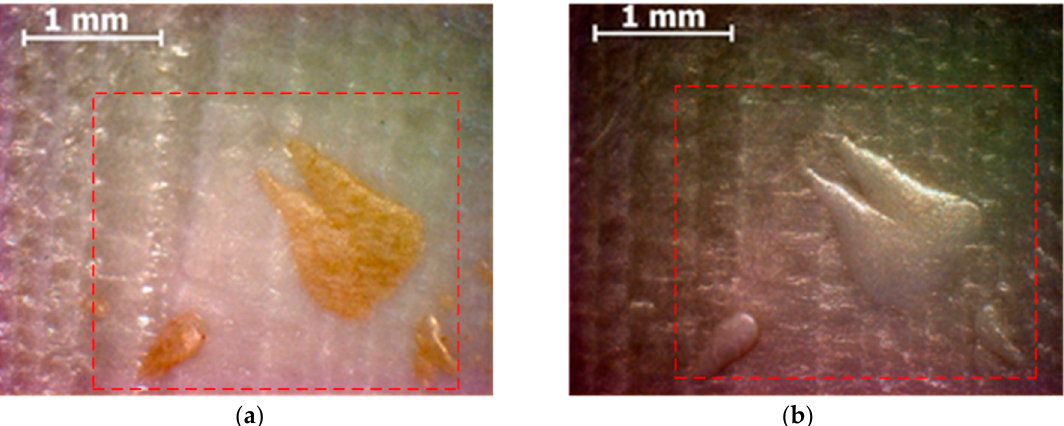
Figure 7. ( a ) Surface scalding patch attached to the part in shot 12. ( b ) Protrusion mold in a similar area, shape, and size because of the surface scalding, in shot 13. The scalded tool material has adhered to the part in ( a ), and hence, the tool has lost